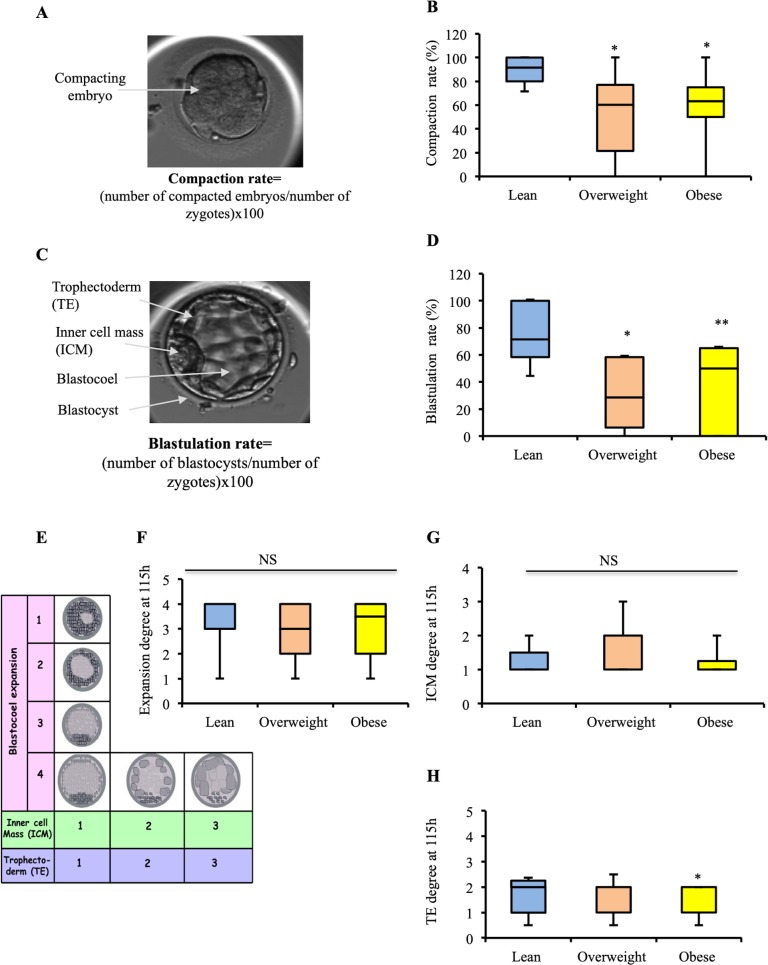
Effect of paternal obesity on the embryo development on day 4 and 5 of culture.(A) Picture of a compacting embryo. (B) Boxplots showing the embryo compaction rate in the different groups. (C) Picture of a blastocyst. (D) Boxplots showing the blastulation rate in the three different groups. (E) Blastocyst grading system used (expansion degree from 1 to 4, inner cell mass (ICM) quality from 1 to 3, and trophectoderm (TE) quality from 1 to 3). (F) Boxplots showing the degree of blastocoel expansion at 115h in the different groups. (G) Boxplots showing the ICM quality at 115 h in the three different groups. (H) Boxplots showing the TE quality at 115h in the different groups. Data are expressed as median ± interquartile range. Stars indicated groups that are statistically significantly different from the lean group (*p<0.05, **p<0.01, ***p<0.001).